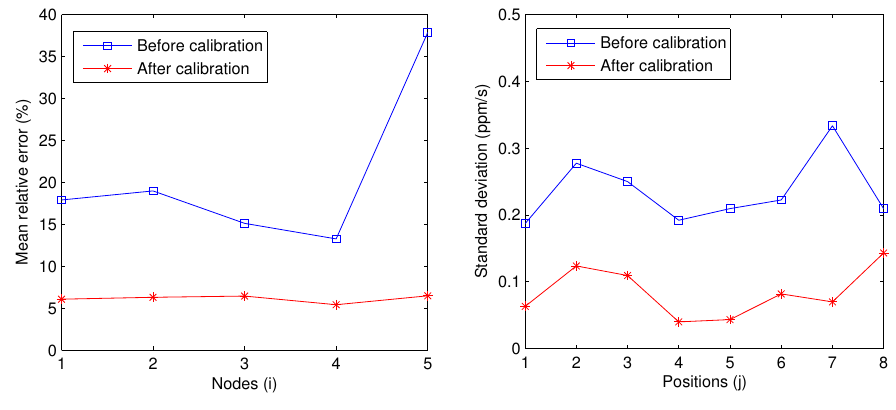
Figure 8. Performance of